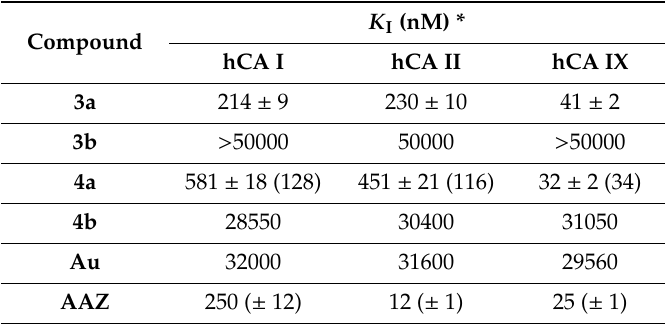
Table 1. CA inhibition data against intermediates 3a and 3b coated nanoparticles 4a and 4b and Au shell against the hCAs I, II, and IX in comparison with the standard CAI AAZ. Data in parentheses refer to the K I values after 2 h of incubation [11].